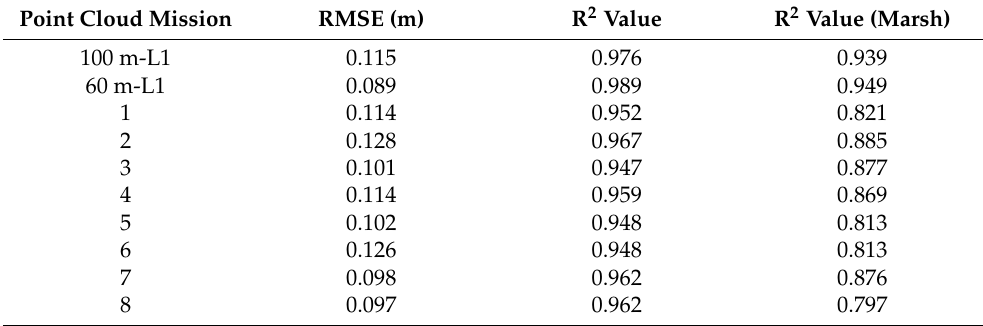
Table 6. Analysis of the LiDAR point cloud accuracy. The estimation of the RMSE includes all the GCPs of the corresponding campaign. RMSE: root mean square error. Marsh: including only GCPs on the marsh surface. Point Cloud